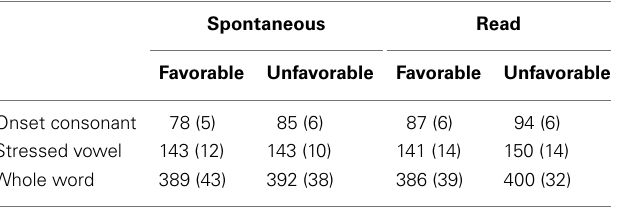
Table 5 | Mean durations in milliseconds (standard errors in brackets) for constituents of the second word of landmark phrases in the semantics condition.